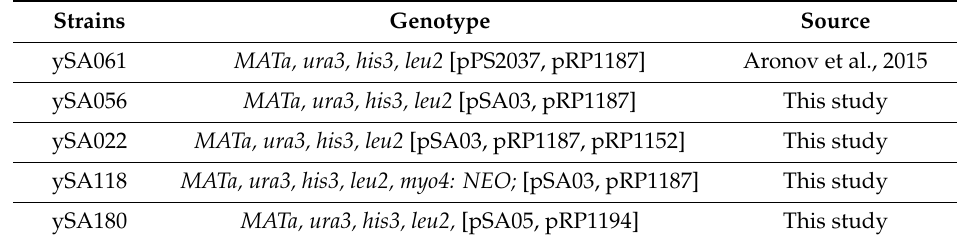
Table 5. S. cerevisiae strains used in the study.